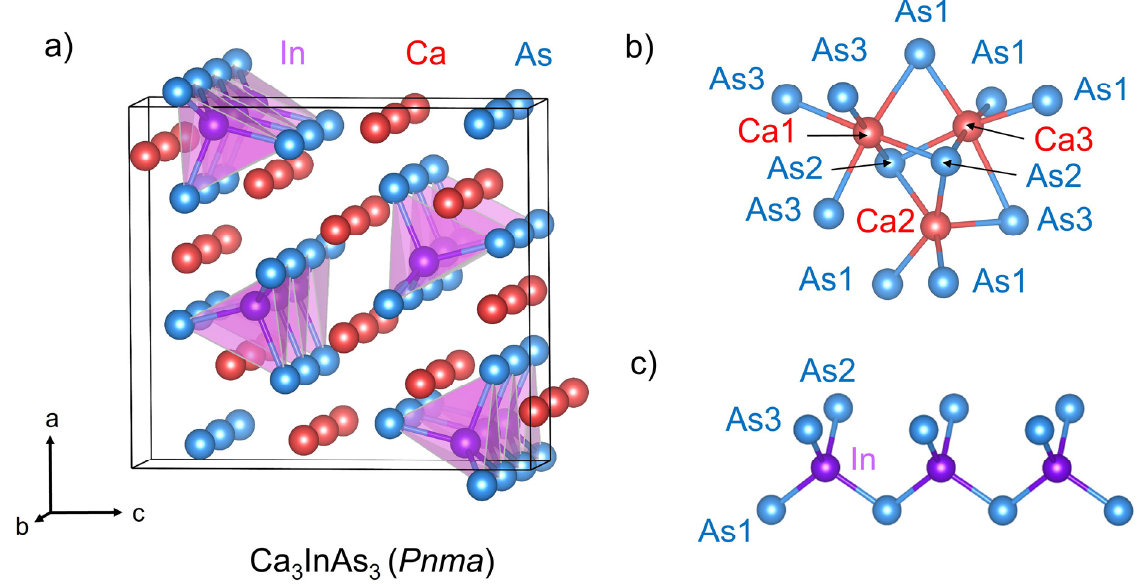
Figure 1. ( a ) A schematic polyhedral representation of the orthorhombic crystal structure of Ca 3 InAs 3 . ( b ) Distinct coordination environments for Ca1, Ca2, Ca3, As1, As2, and As3. ( c ) The InAs 4 tetrahedra and the way they are linked (corner-sharing of the As1 atoms). The As-In-As angles deviate from the ideal 109.5 ◦ of a regular tetrahedron. As1-In-As2, As1-In-As3, and As3-In-As2 angles measure 108.81(2) ◦ , 116.53(2) ◦ , and 98.12(2) ◦ , respectively. Interatomic distances can be found in Table